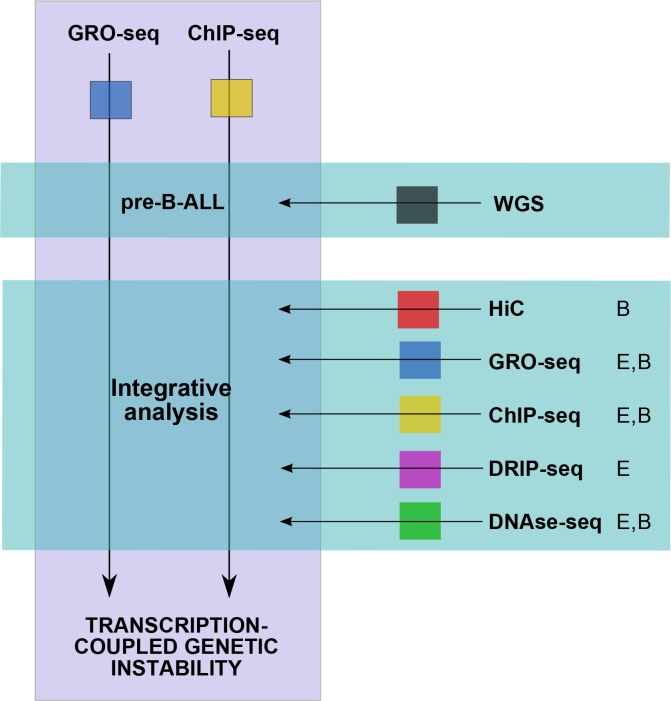
Summary of data used in the integrative analysis.GRO-seq and ChIP-seq data were generated from pre-B-ALL cells (Supplementary file 1) for studying transcription-coupled mechanisms in context of leukemia SV. The SV data was retrieved from four published WGS studies (Holmfelt et al., 2013; Papaemmanuil et al., 2014; Andersson et al., 2015; Paulsson et al., 2015) and jointly analyzed with the signal profiles. To distinguish domains in the genome with high SV frequency, HiC data was retrieved from B-lymphoblastoid cells (Rao et al. 2014) and used to define TADs (Figure 1—source data 1). This initial analysis led to the identification of specific transcription signal features that occur frequently at breakpoints (convT and Pol2 stalling, Figure 2—source data 1). In order to characterize the properties of convT and Pol2 stalling sites genome-wide, additional analysis utilized further genomic profiles from B-lineage (B) and ES (E) cells (The ENCODE Project Consortium, 2012; Ginno et al., 2013). Inclusion of normal cell types allowed us to control for possible caveats in analyzing the signal from complex cancer genomes. In addition to the data shown, RSS and RLFS sequence motif analysis was used to distinguish DNA-encoded features.